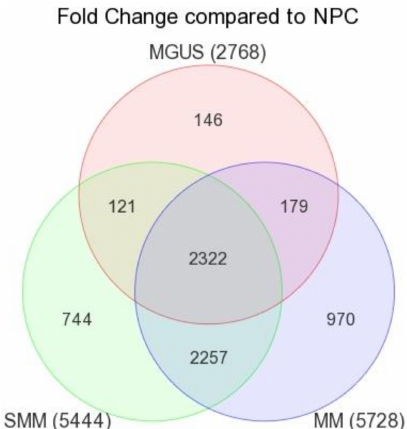
Figure 1. Gene expression analysis of MGUS, SMM and MM samples. Gene expression profiles of CD138-selected plasma cells from the bone marrow from 351 newly diagnosed MM, 22 SMM, 44 MGUS and 22 healthy donors (NPC) were compared. Diagram represents genes with a 1.5 fold or greater difference across each subgroup. Gene expression was compared across the three subgroups to identify overlapping genes within each disease subgroup and genes unique to each subgroup. Significance was determined as p < 0.05 with an FDR < 0.05 as determined by a student’s t